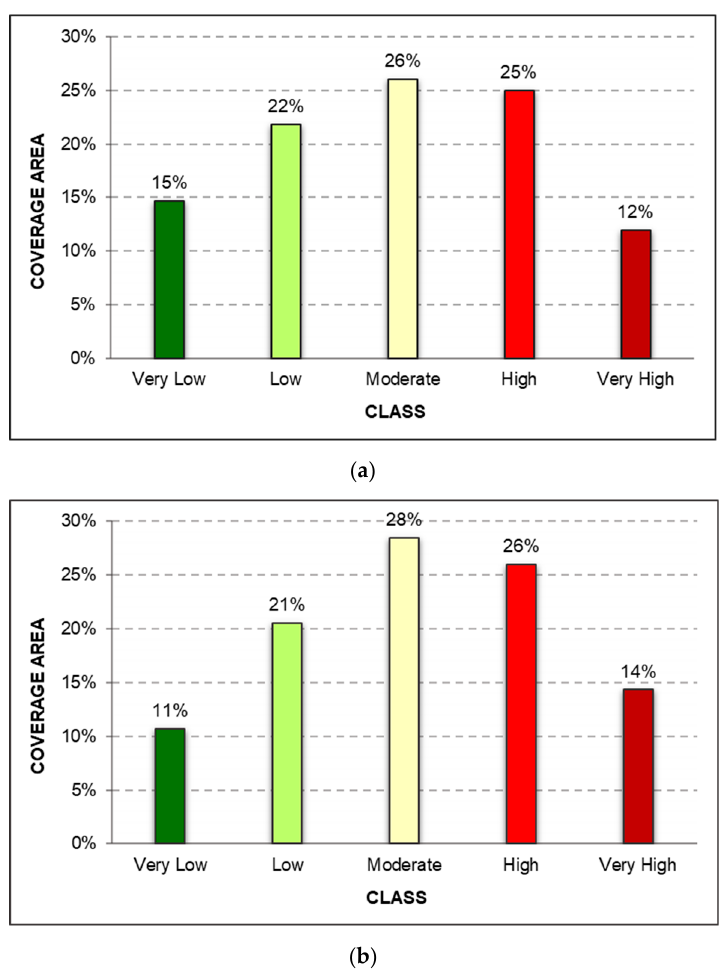
Figure 8. Diagrams with the coverage area percentages of the landslide susceptibility classes for the models: ( a ) hybrid GeoDIV model; ( b ) individual IV model.